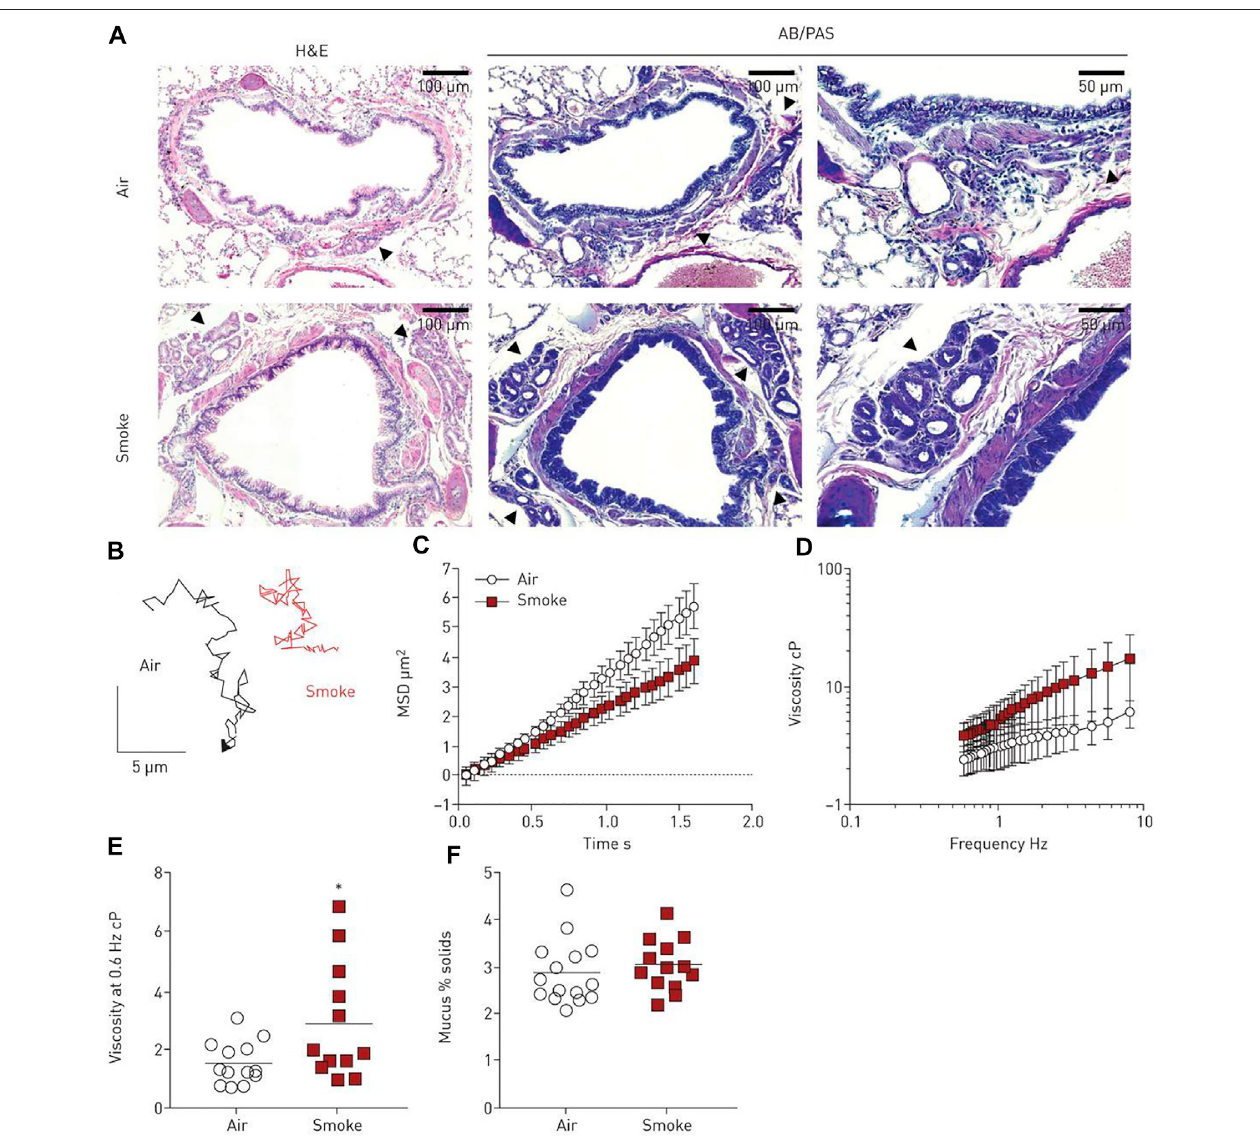
FIGURE 4 | Mucus viscosity increases with smoke exposure in ferrets. (A) Histology of tracheal and lung tissue samples from control and smoke-exposed ferrets. Submucosal glands areindicatedby theblack arrows. (B) SampleBrownian motionVPT tracksof500 nm diameter tracerprobes imbedded in themucus ofboth ferret groups. (C) MSD asafunction oflag time and (D) effectiveviscosity asafunctionoffrequencyforthe controland smoke-exposedferretgroups. (E) Effective viscosity of bothmucusgroupsatafrequencyof0.6 Hz. (F) Percentsolidcontentofmucusgroups,calculatedfromwetanddryweights. N =12 – 15ferretspergroup, p < 0.05 (unpaired Student ’ s t-test). Figure reproduced with permission of the © ERS 2022: European Respiratory Journal Jan 2020, 55 (1) 1900419; DOI: 10.1183/ 13993003.00419-2019.